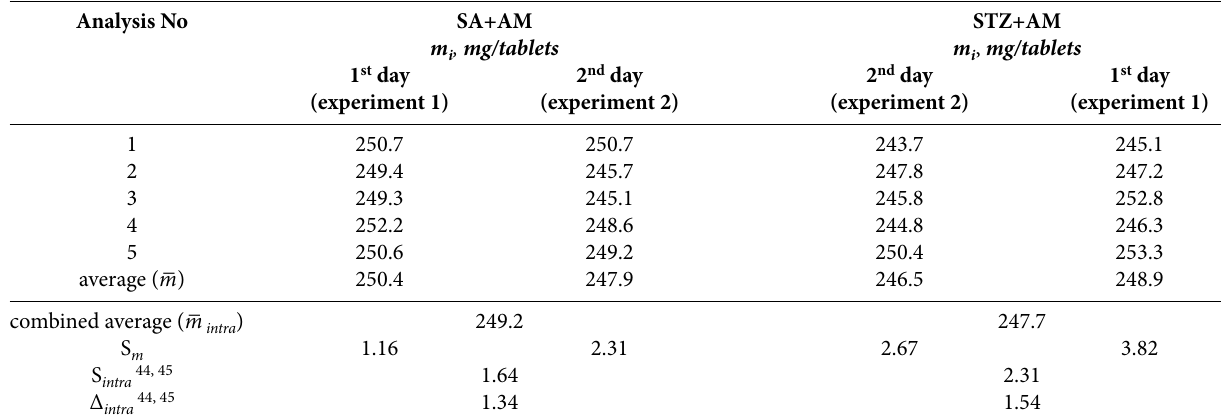
Table 9. Test results of the intermediate precision of AM quantitative determination in “Amoxil”